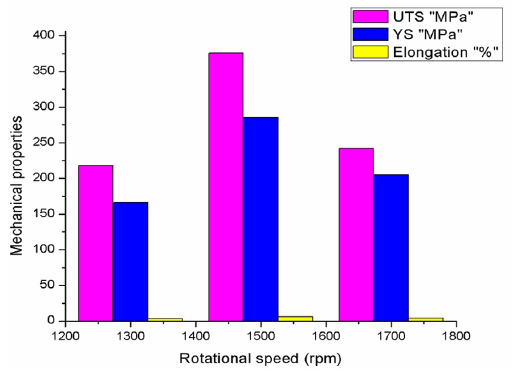
Figure 10: Effect of shoulder diameter on tensile strength